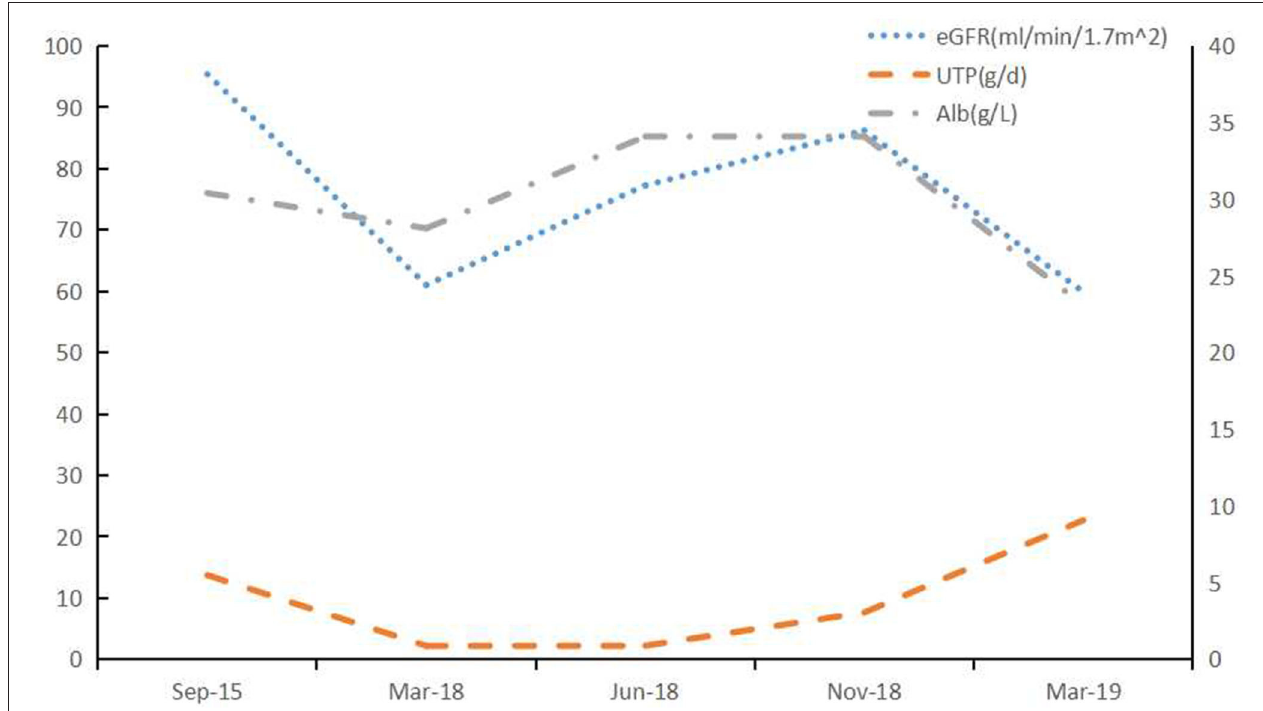
FIGURE 4 | Clinical course of Case 2. After treatment with lenalidomide, the renal impairment and proteinuria caused by LCDD was aggravting. BCD: bortezomib (2mg, once weekly), cyclophosphamide (200mg, once weekly), and dexamethasone (20mg, once weekly); Rd: lenalidomide (25mg daily, on Days 1 through 21 of each 28-day cycle) and dexamethasone (20mg once